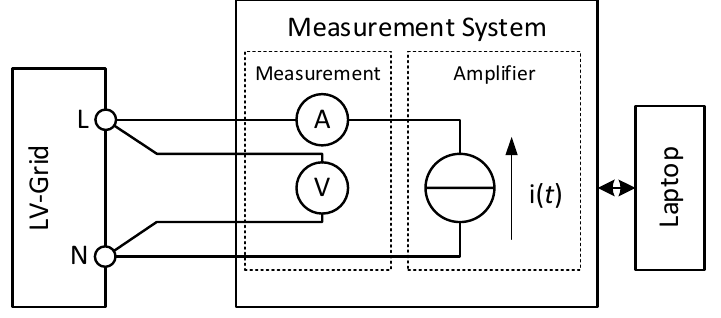
Figure 5. Scheme of the TUD measurement system.